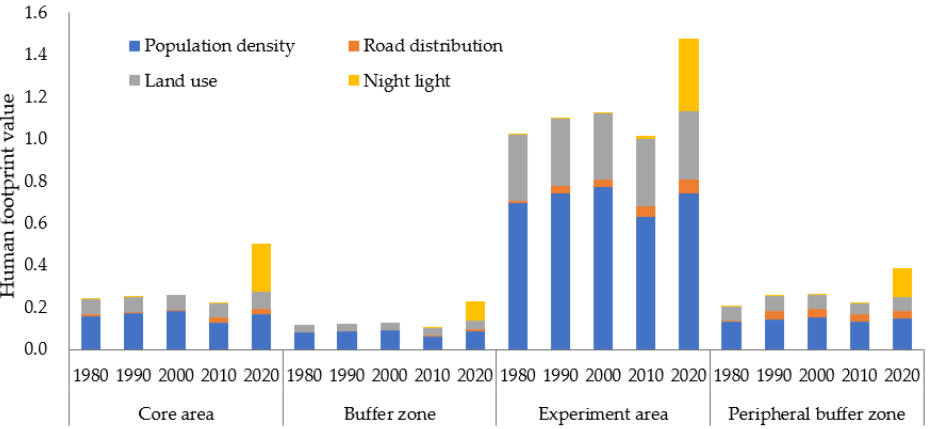
Figure 4. Disturbance intensity to the ecosystem of each functional zone in the Qilian Mountains Nature Reserve from 1980 to 2020.